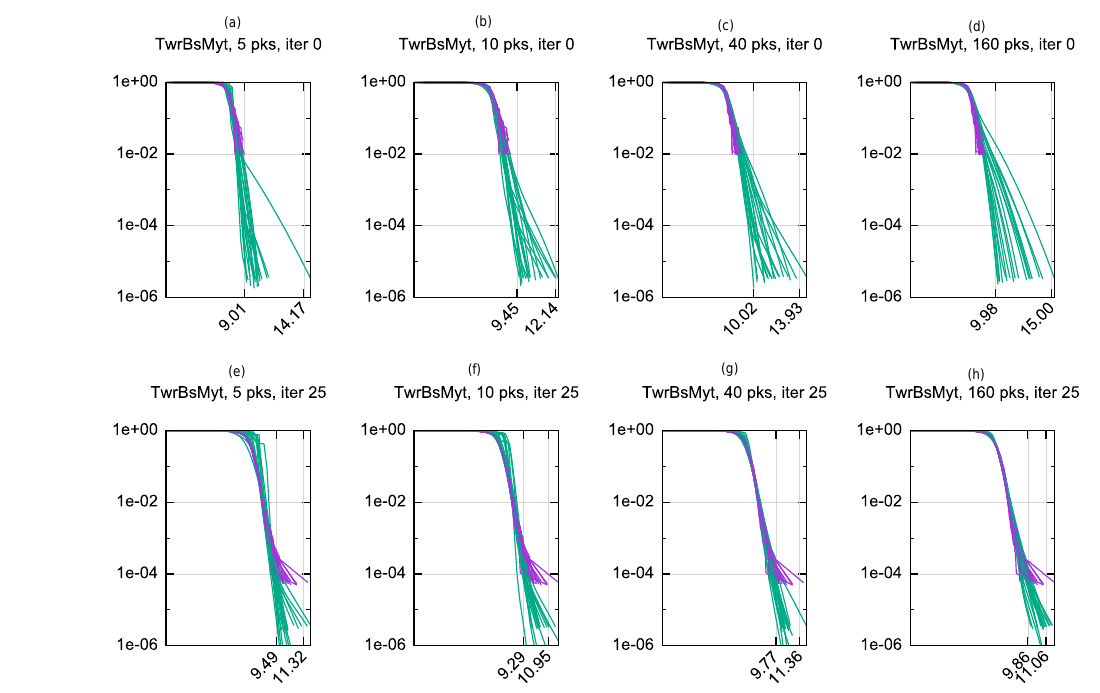
Figure 5. Behavior of ASIS and iterative updating of extrapolation for fore–aft tower base load over 20 separate runs. The x -axis units are 10000s of kilogram newton meters; the y axis is probability of exceedance in 10min. The format is the same as Fig. 4. Again it is interesting to compare the visual representation with the statistics presented in Fig. 3. The single extremely large load discovered by ASIS was also seen in Graf et al. (2017) (f) . Though it is beyond the scope of the present paper to do so, one of our main conclusions is that the statistical methods have come to a point at which the best course forward will be to pursue the exact causes of such loads and integrate a statistical description of such situations into our